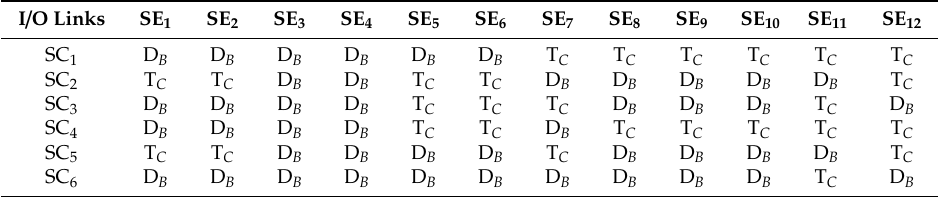
Table 4. Switching combinations of OSEs for particular I/O links in the 6-port optimized HCROS.